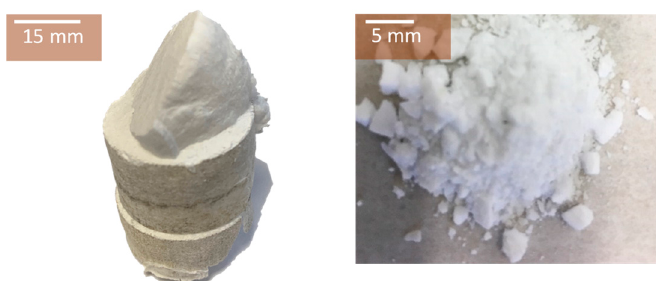
Figure 5. The structure of MSH pellets after four hydration / dehydration cyclic tests. Left: 25 mm diameter prepared under a compression pressure of 5.2 kN ⋅ mm − 2 ; Right: 12 mm diameter prepared under a compression pressure of 0.77 kN ⋅ mm − 2.